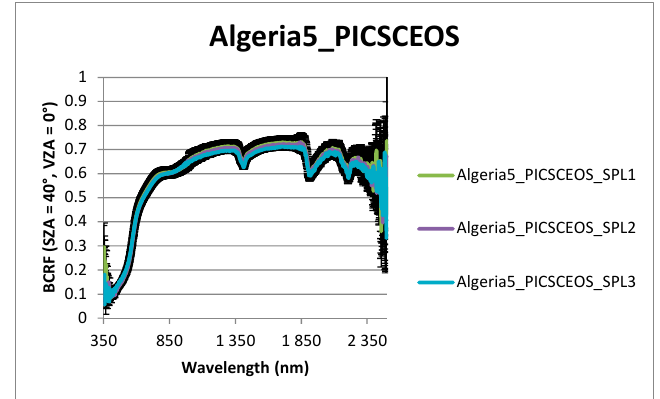
Figure 5. Algeria5_PICSCEOS BCRF discrepancy between samples compared to one measurement